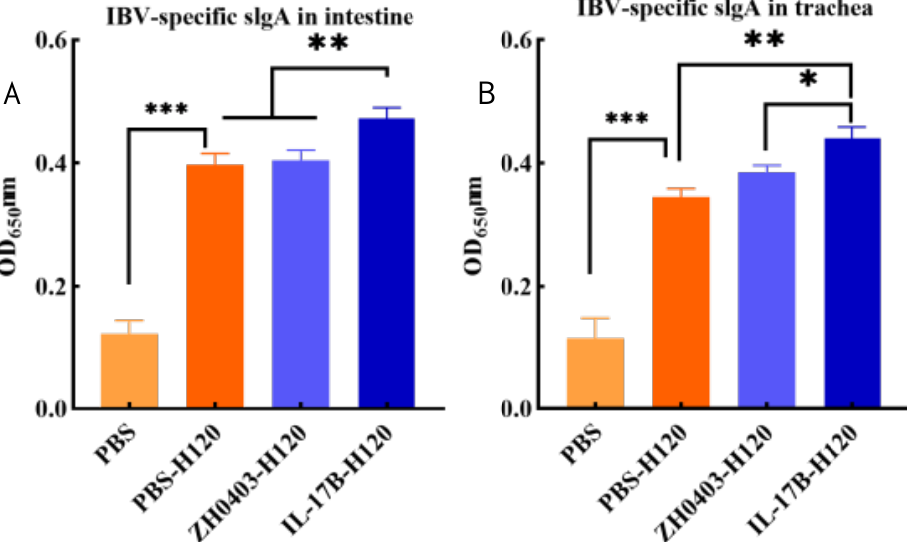
Figure 10. The IBV-specific sIgA titers measured via ELISA under 620 nm wavelength in the intestine ( A ) and trachea ( B ). The error bars represent mean values±SD of each group. One-way ANOVA with Tukey’s test was used for statistical analysis; * : p < 0.05; **: p < 0.01, ***: p < 0.001.